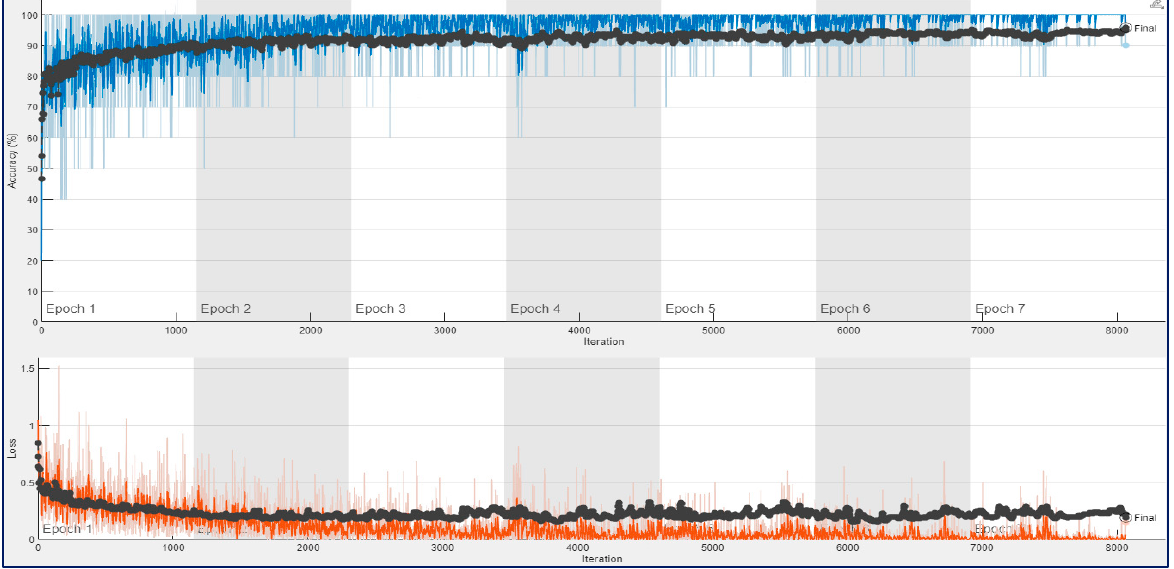
Figure 11. Training process result for ResNet18 with 12,800 spectrogram images in a trial on the 10-FCV.